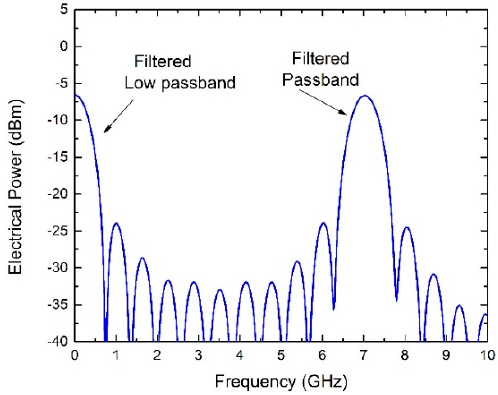
Figure 7. Frequency response of the MPF on the lower arm simulated by VPIphotonics [10].